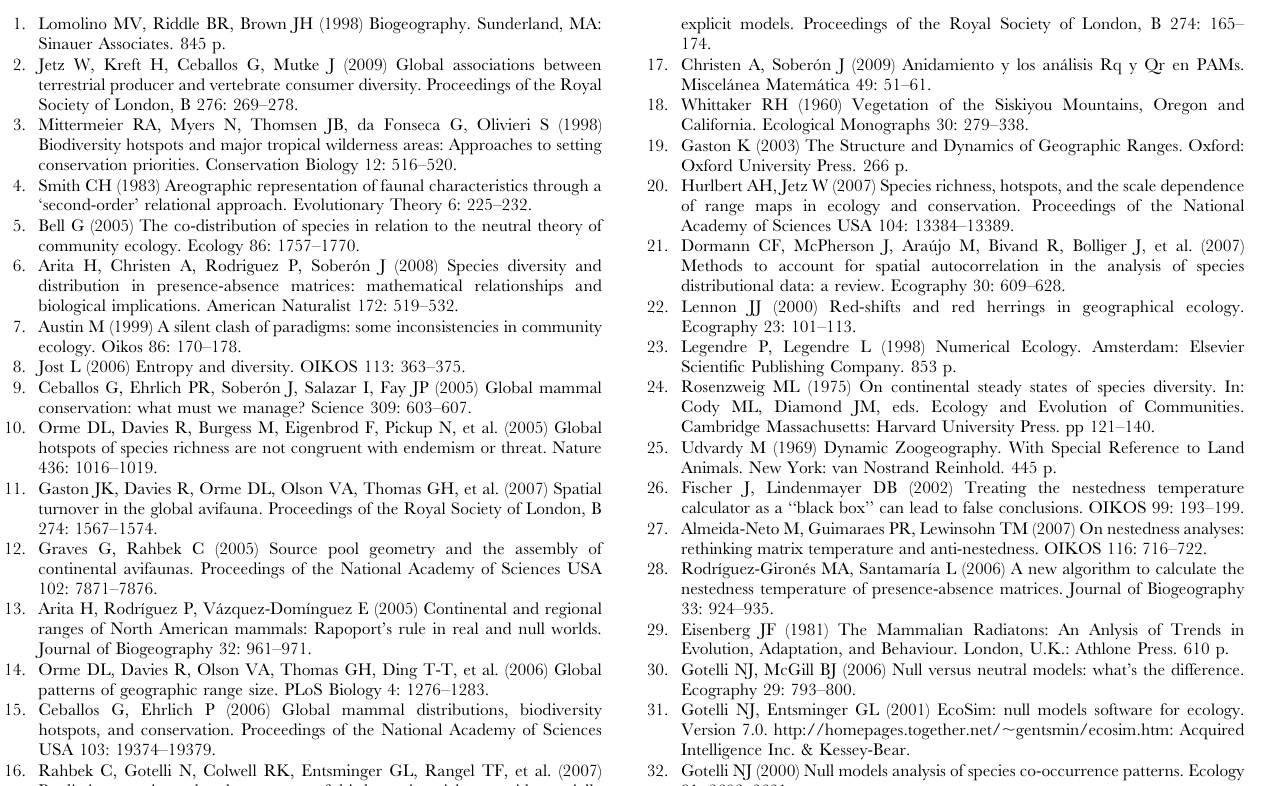
Figure S1 Extreme covariances and corresponding geographic regions for the Palearctic and Afro Tropical Regions. Histogram of covariances 6 10 4 (right column) and corresponding regions in the map, displaying the fact that extreme values of covariance are associated to large, contiguous regions of similar ecological conditions (high covariance, purple) or to islands or peripheral regions of regions (low covariance, orange). Figure S2 A histogram of the range of values for the range in mean covariance in 100 EcoSim randomizations (A), and in the observed Nearctic PAM